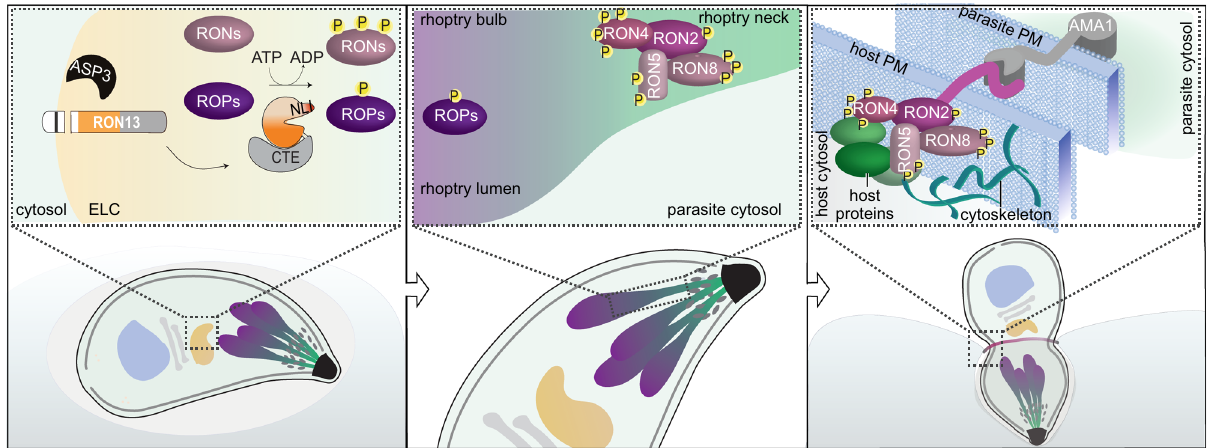
Fig. 10 Cartoon summarizing the main fi ndings. Left: in the endosome-like compartment (ELC) where protein traf fi cking to secretory organelles is determined, Asp3 protease cleaves the N-terminal transmembrane segment of RON13. Rhoptry proteins, including RONs and ROPs (violet tones), are phosphorylated by RON13 within this compartment. Center: RON13-phosphorylated proteins assemble to form the RON complex within the rhoptry neck, prior to being secreted into the host. Right: the RON complex, localized to the cytosolic face of the host, contributes to parasite invasion by forming a moving junction by associating with adhesins at the parasite plasma membrane (blue). Phosphorylated proteins of the RON complex additionally recruit host proteins (green) to assist in parasite invasion and subvert host cellular